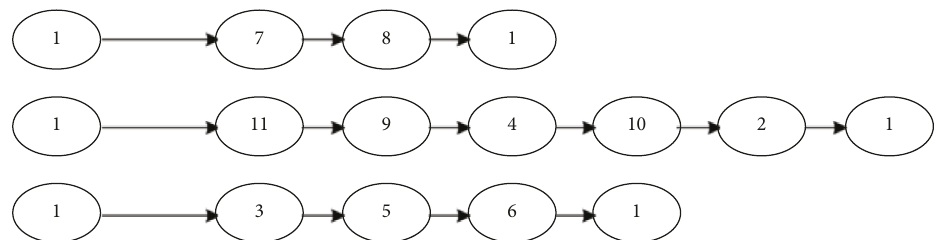
Figure 3: Details of the routes formed in the second